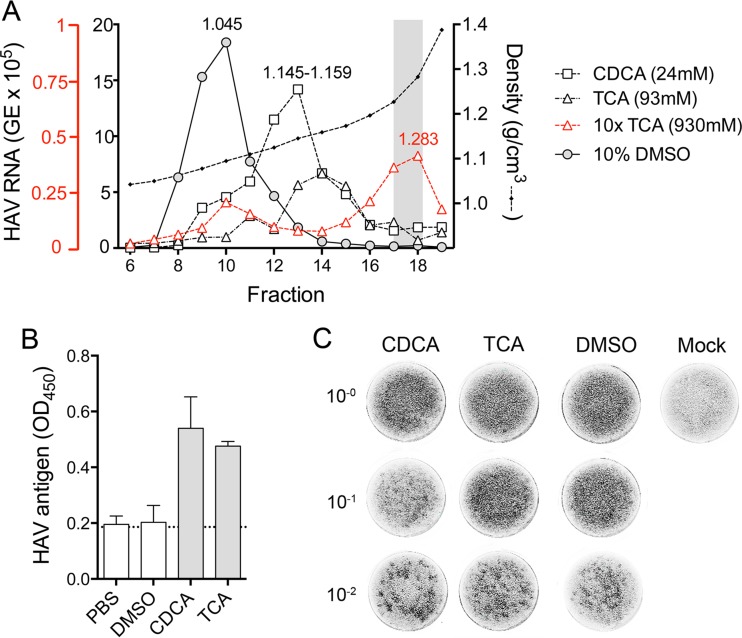
Stability of quasi-enveloped eHAV in human bile acids. (A) Quasi-enveloped eHAV virions were incubated with chenodeoxycholic acid (CDCA; 24 mM), taurocholic acid (TCA; 93 mM or 930 mM), or DMSO (10%) at 37°C for 2 h. The virus was then centrifuged to equilibrium in isopycnic iodixanol gradients. The buoyant density of virions was determined by measuring the quantity of HAV RNA in fractions 6 to 19 by RT-qPCR. The distribution of virus in the DMSO-treated sample matched that of virus incubated in PBS alone (not shown). The shaded zone indicates the expected density of nonenveloped HAV virions. (B) HAV capsid antigen ELISA of gradient-purified eHAV following treatment with bile acids. Virus samples (approximately 2 × 107 GE) were subjected to diafiltration to remove bile acids and then tested for the presence of detectable (exposed) capsid antigen by ELISA (see Materials and Methods). (C) Infectivity of eHAV following treatment with bile acids. Samples were subjected to diafiltration to remove bile acids and then diluted and inoculated onto FRhK-4 cells for IR-FIFA. The content of the 10−2 dilution of the CDCA-treated sample was 3.8 × 104 GE/ml, that of the 10−2 dilution of the TCA-treated sample was 3.1 × 104 GE/ml, that of the 10−2 dilution of the DMSO-treated sample was 2.3 × 104 GE/ml, and that of the 10−2 dilution of the PBS-treated sample was 3.6 × 104 GE/ml.